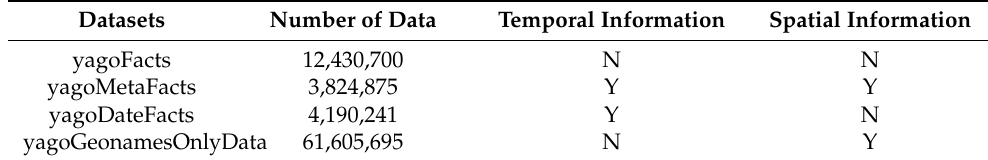
Table 2. Statistics of the four real datasets.